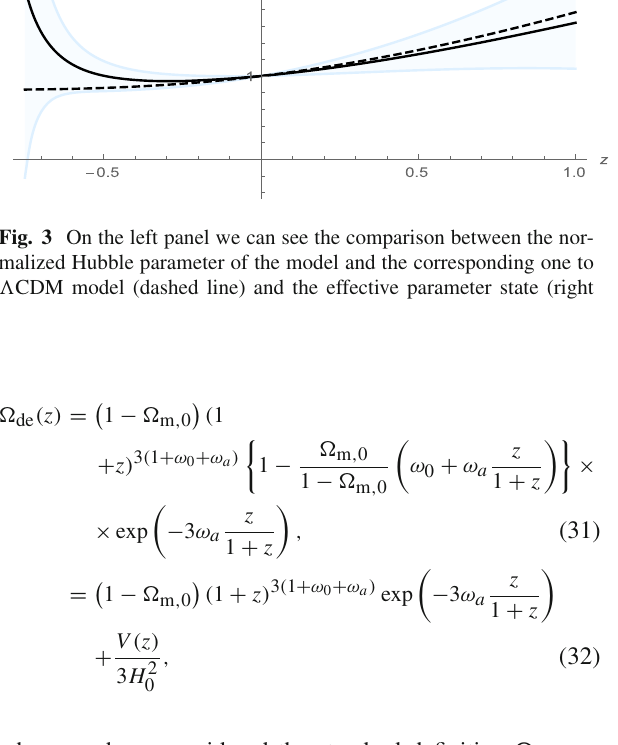
panel) for the case δ = − 1. The black solid line in each panel corre- sponds to the best fit values for the parameters of the model and the shaded regions correspond to the errors propagation